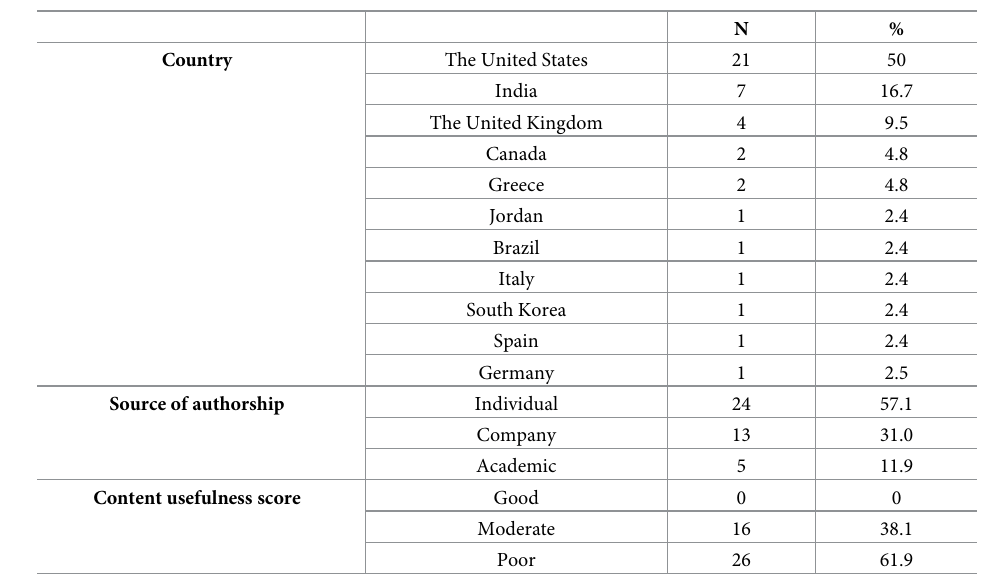
Table 2. Video characteristics.